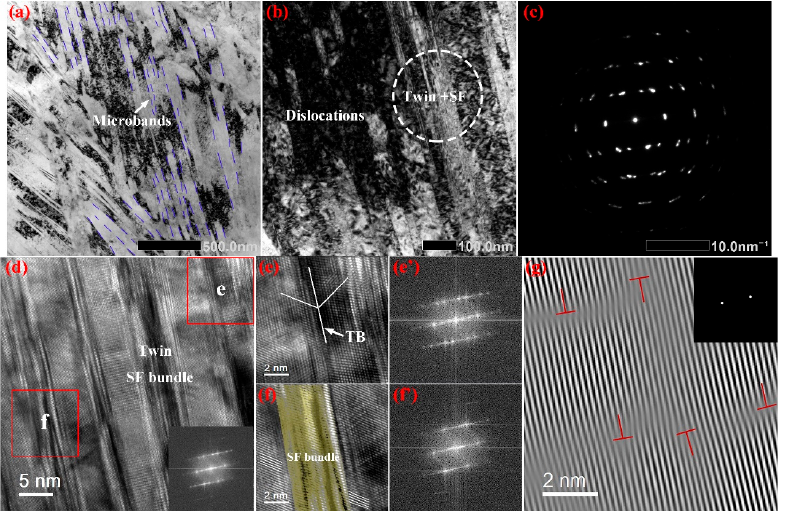
Figure 8. Microstructural features of an uncharged CoCrFeMnNi sample near the fracture surface. Bright-field TEM images showing microbands with a number of dislocations ( a ) and twinning ( b ); ( c ) Selected area electron diffraction; ( d ) A high resolution TEM image showing twinning and stacking fault (SF) bundles; ( e , f ) Enlarged images of the regions ( e , f ) in ( d ), showing twin boundary (TB) and SF bundle; ( e ′ , f ′ ) showing corresponding FFT in ( e , f ); ( g ) edge dislocations marked by red color. Metals 2022 , 12 , x FOR PEER REVIEW